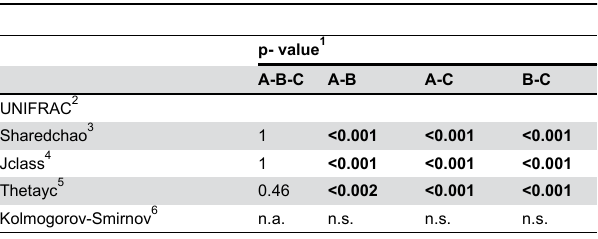
Table 3. Tests for similarity of PLS allele distribution and richness between